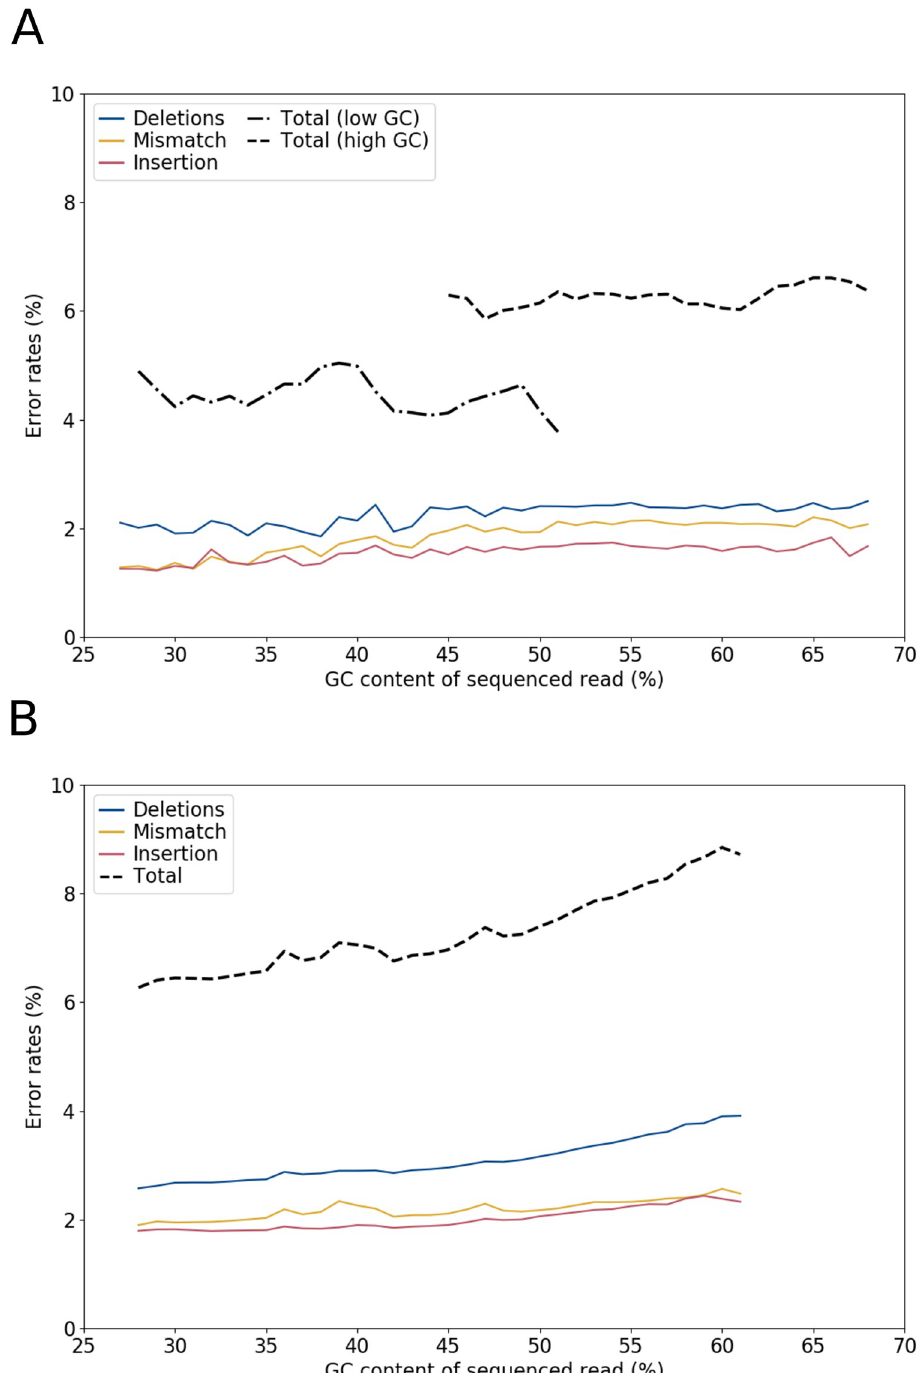
Fig 4. Global error rates of reads according to their GC content. GC contents were grouped by integer value. Only values supported by at least n reads were plotted. For each species the mean error rate is computed, and the median on all this values is displayed. A : Results for bacterial data, n = 100. Low-GC species have lower global error rates than high-GC ones. B : Results for human data, n = 1,000. Error rates show a correlation with the GC content of reads.